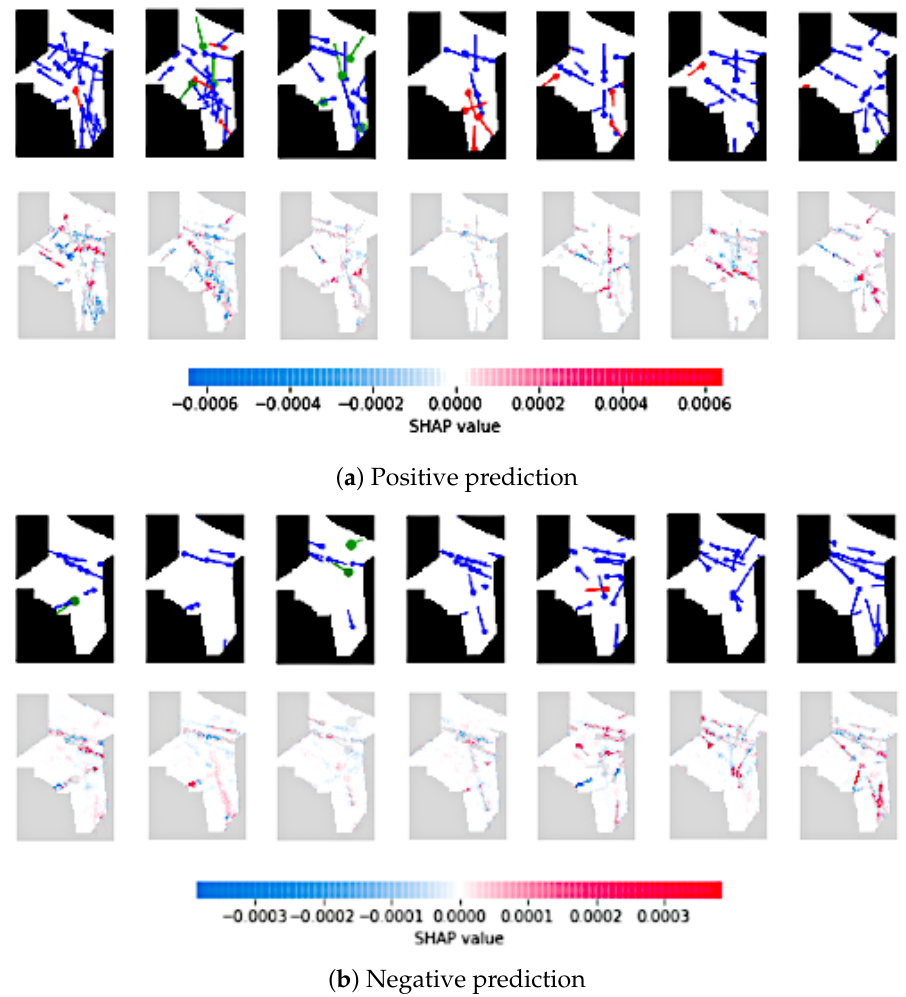
Figure 20. Input images and corresponding SHAP values of the CNN-based model for ( a ) a positive prediction and ( b ) a negative prediction. All images belong to the same 30 min interval, but with a granularity of five